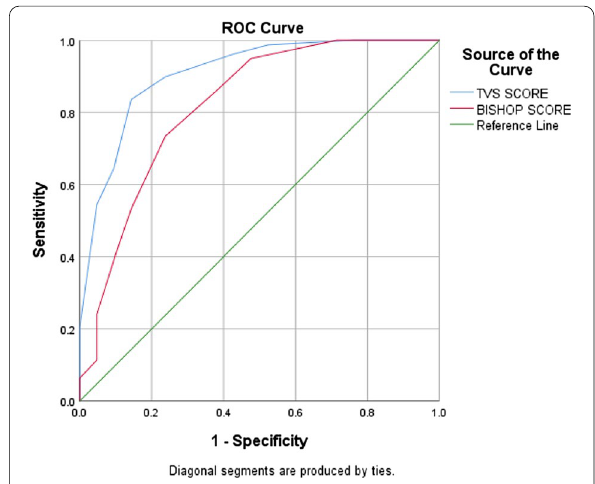
Fig. 3 Receiver–operating characteristic curves for the correlation of TVS score with Bishop Score